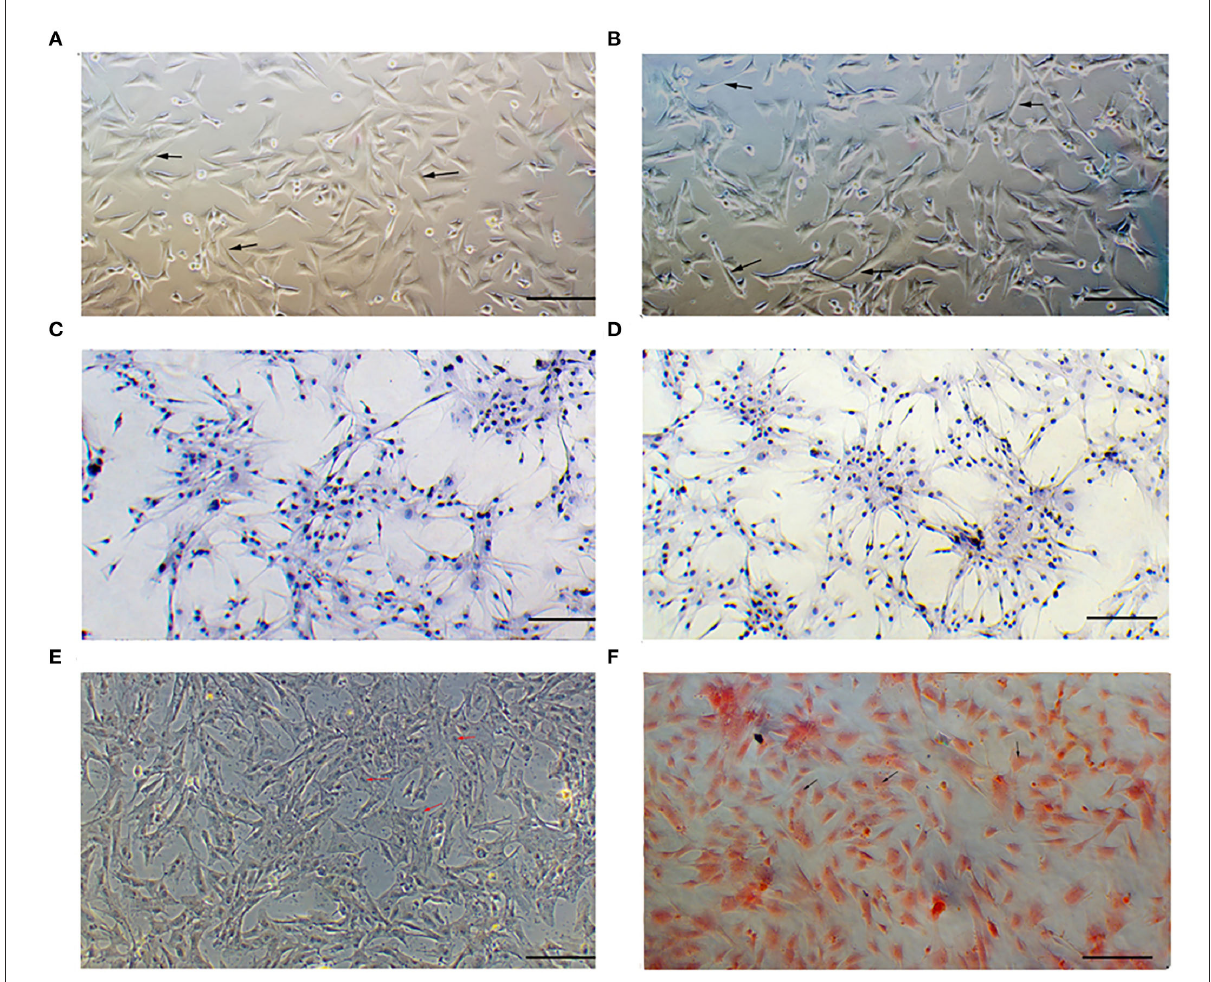
FIGURE1 Identification of melanocytes cultured in vitro . (A) Morphology of cells isolated from skins with white hair as observed under a microscope. (B) Morphology of cells isolated from skins with brown hair as observed under a microscope. (C,D) S100 protein signaling detected by